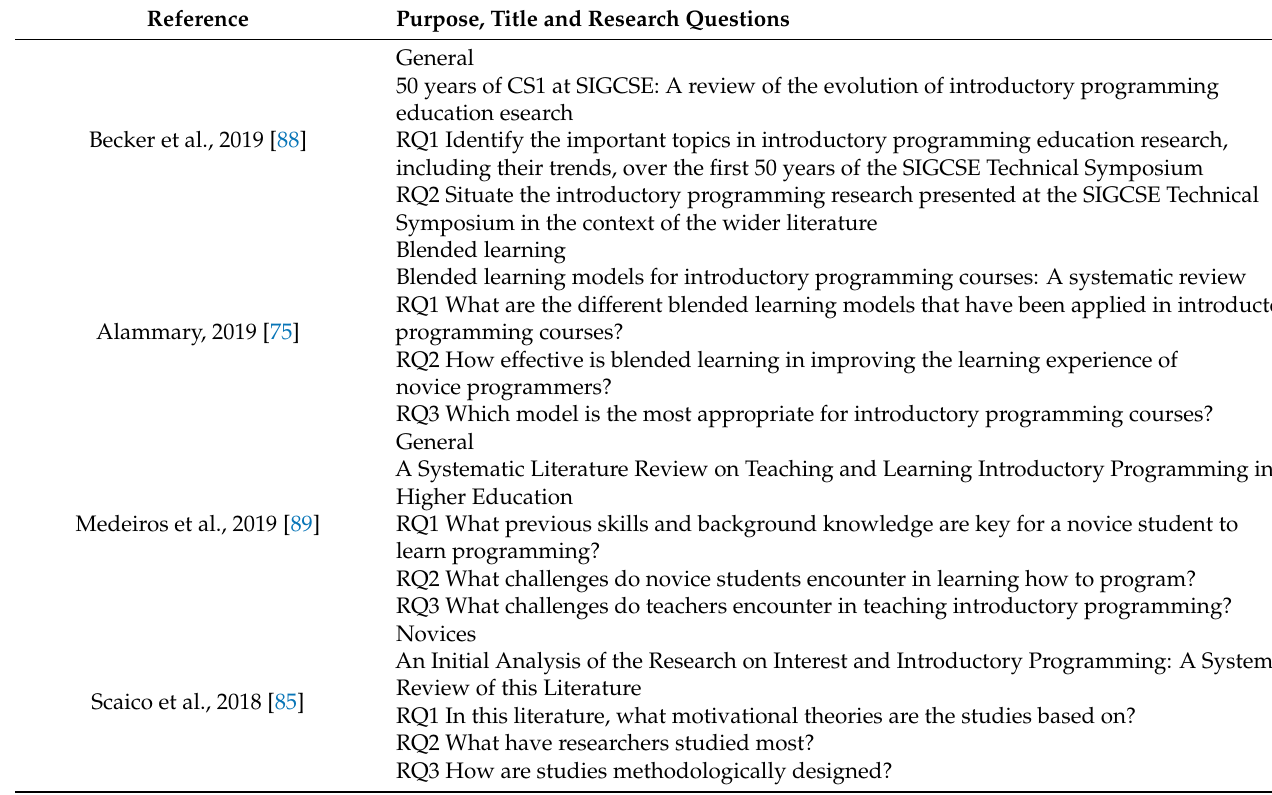
Table A1. Reference, Purpose, Title and Research